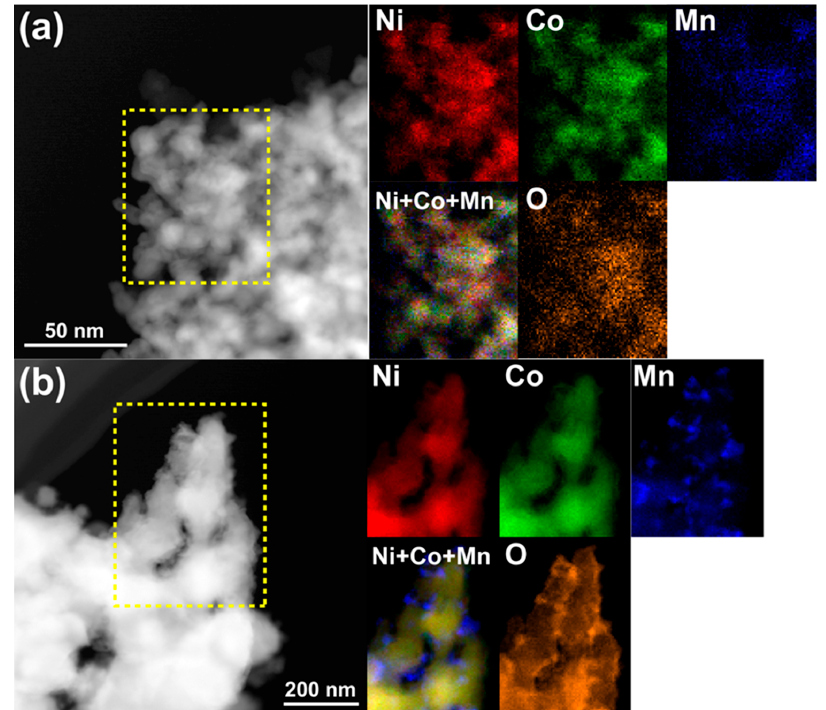
Figure 3. STEM images and energy dispersive X ‐ ray spectrometry (EDS) chemical maps of the highlighted areas showing the distributions of Ni (red), Co (green), Mn (blue), and O (orange) from Ni ‐ K, Co ‐ K, Mn ‐ K, and O ‐ K, respectively, in NP ‐ NiCo ( a ) before the catalysis test and ( b ) after the test. Combined images of Ni, Co, and Mn are also shown.